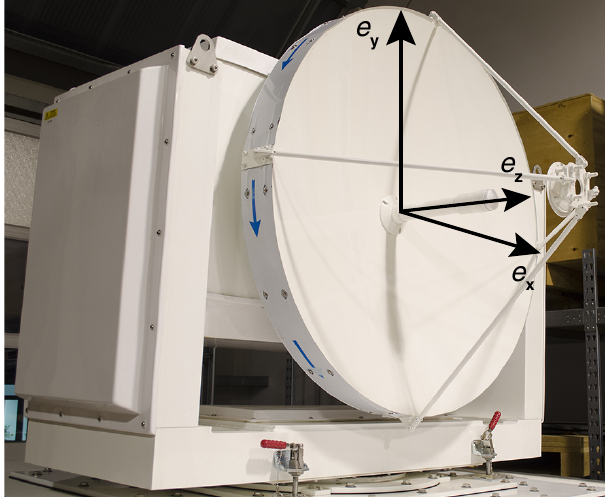
Figure 3. Antenna of MIRA-35 system mounted on the scanning unit. The description polarization basis is shown. The unit vector e z shows the propagation direction of the transmitted